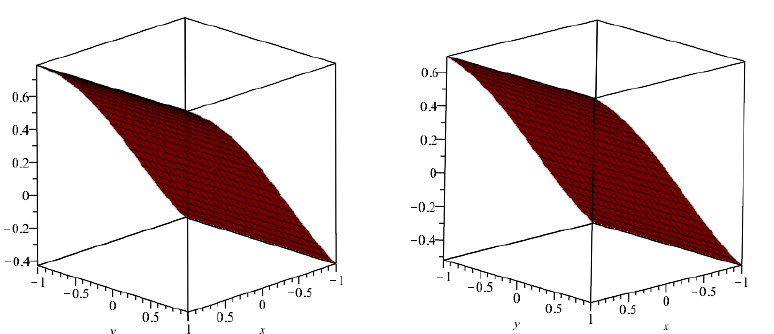
Figure 5. Behavior of the exact and analytical solutions for problem 2 at β = 1.